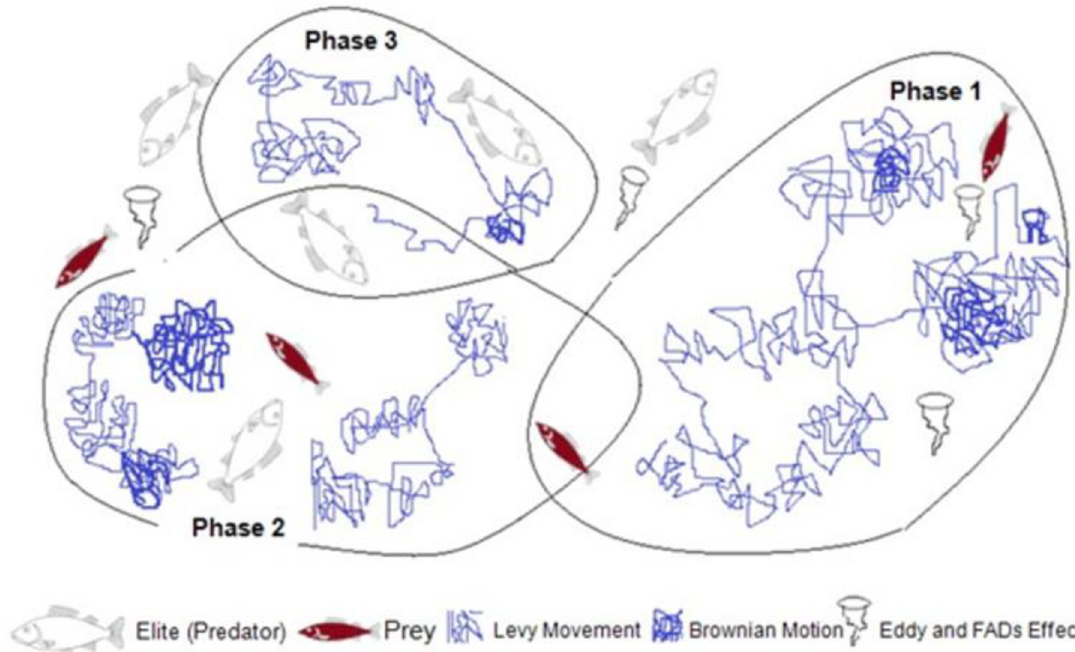
Fig 1. Several optimization phases of the proposed